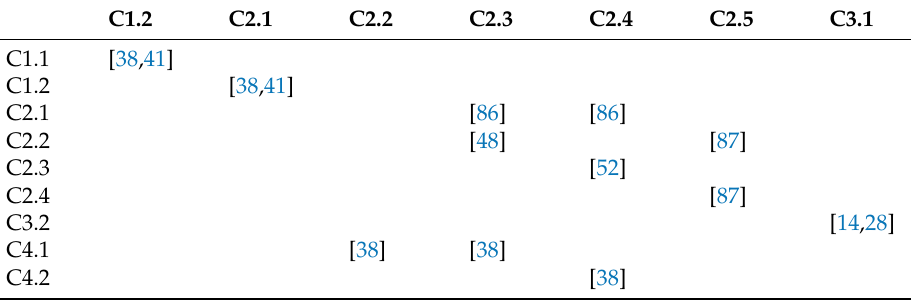
Table 7. Dependencies between sub-criteria based on the literature